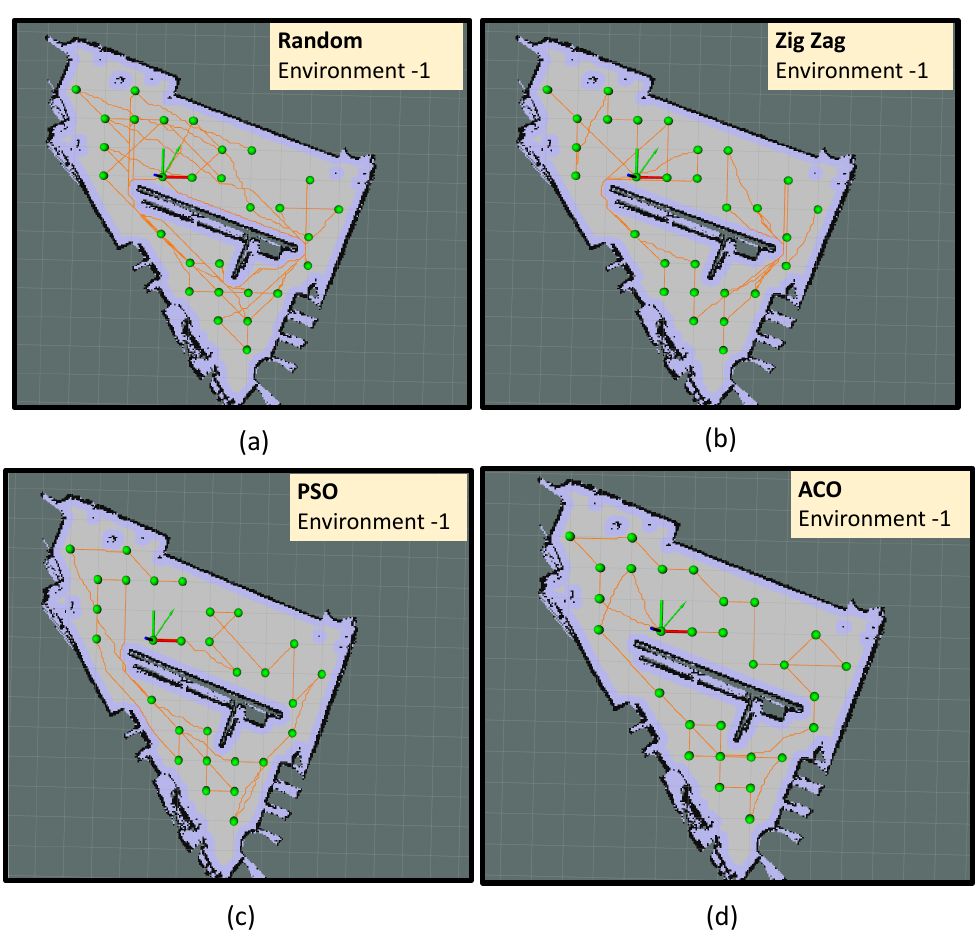
Figure 12. The path followed by the robot in environment-1 using random selection of points ( a ), using zig-zag selection of points ( b ), PSO algorithm ( c ), and ACO algorithm ( d